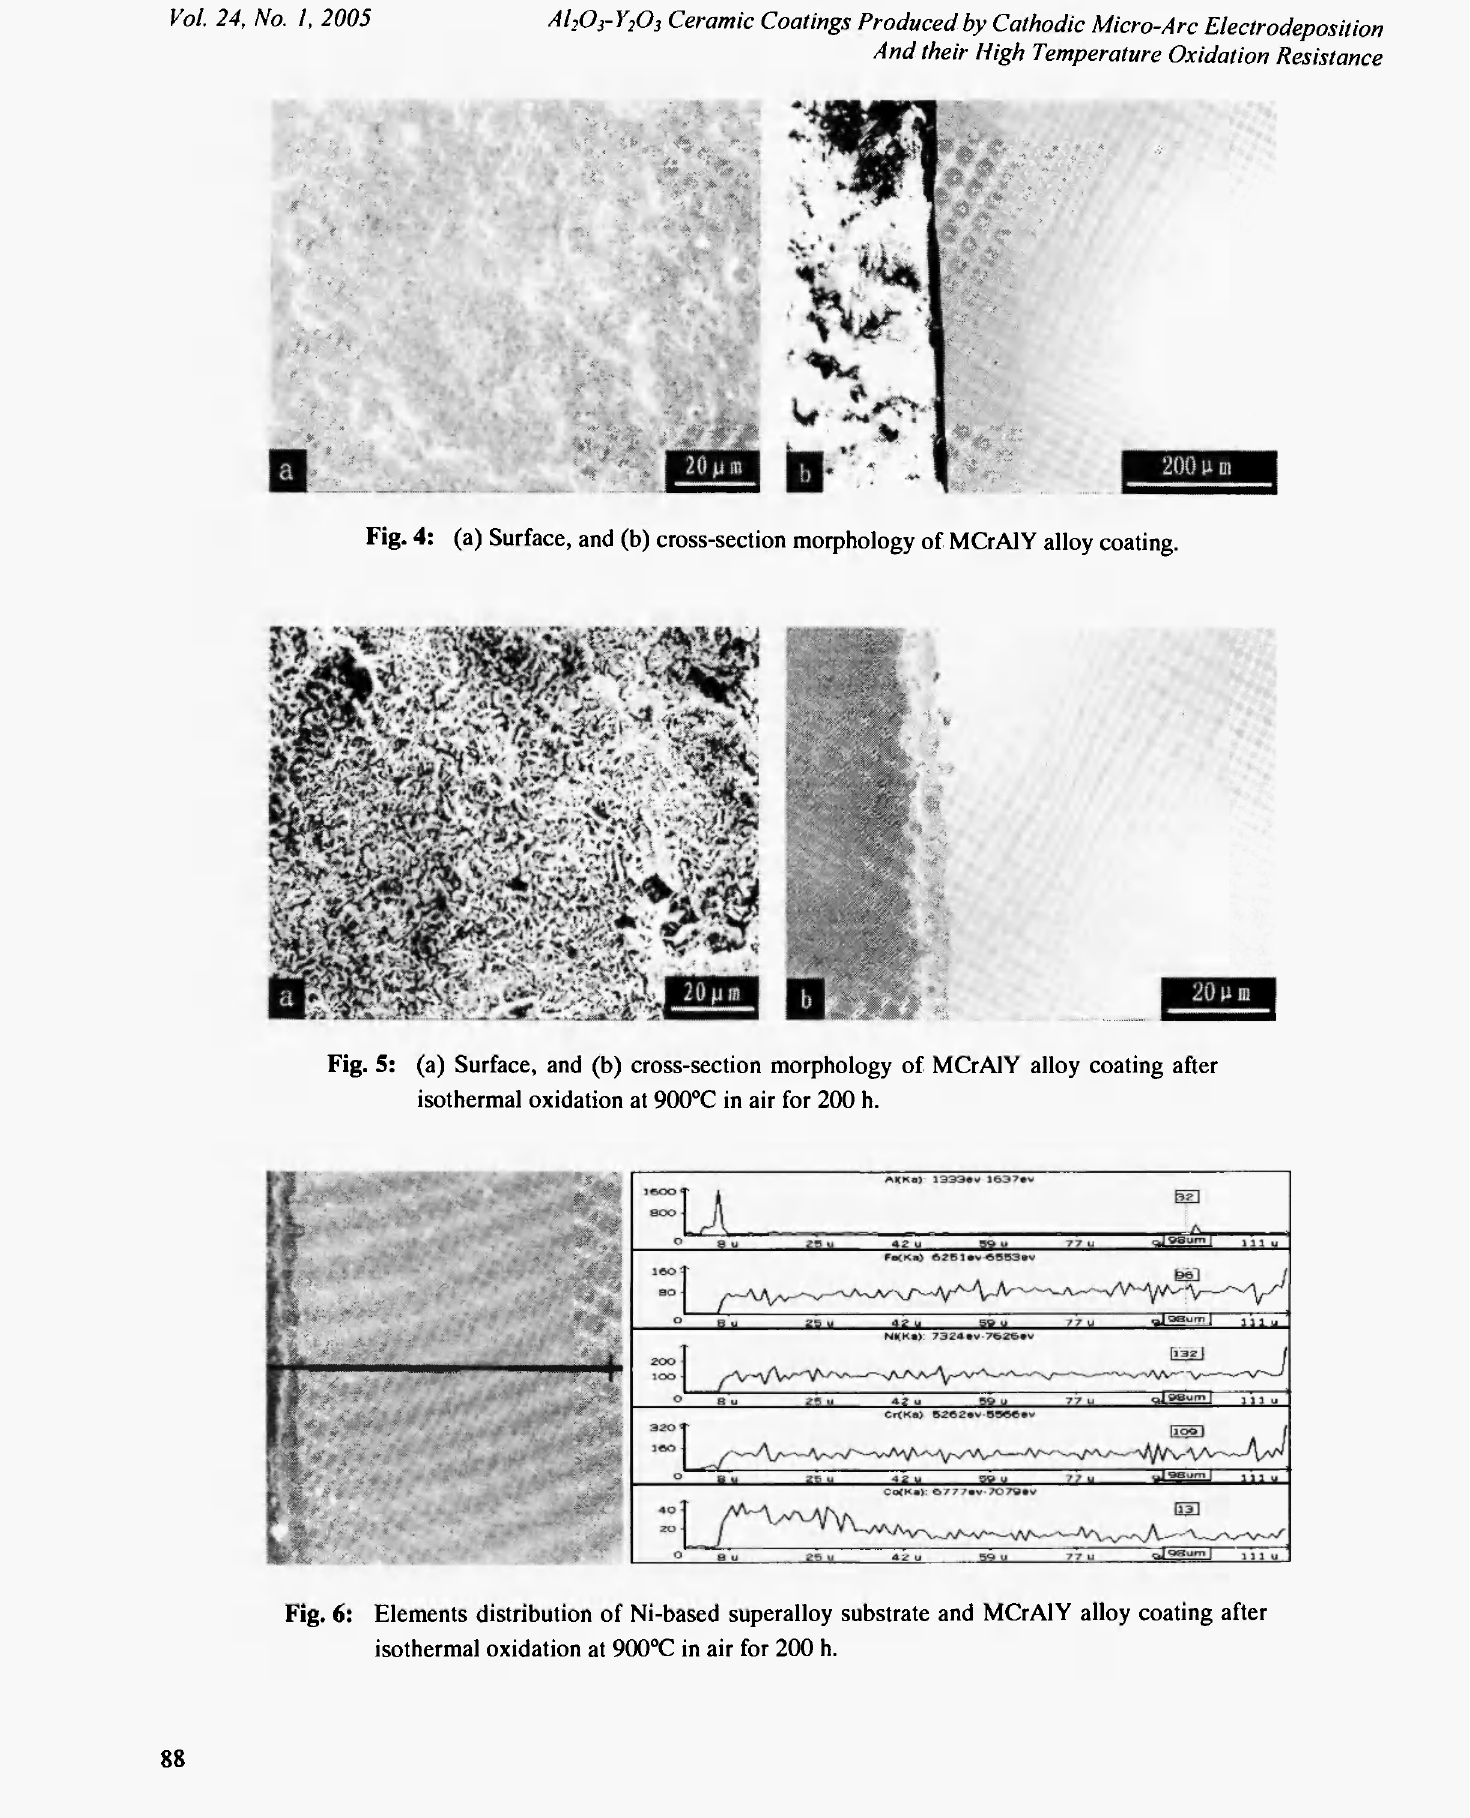
Fig. 4: (a) Surface, and (b) cross-section morphology of MCrAlY alloy coating.